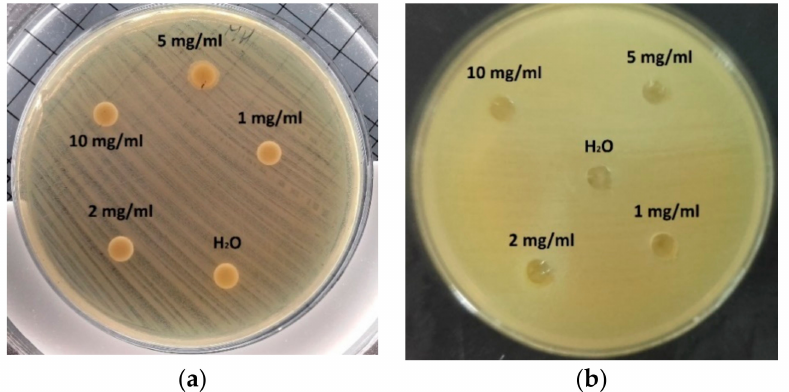
Figure 3. Antimicrobial activity of CH against S. aureus : ( a ) disc diffusion method, ( b ) well diffusion method.